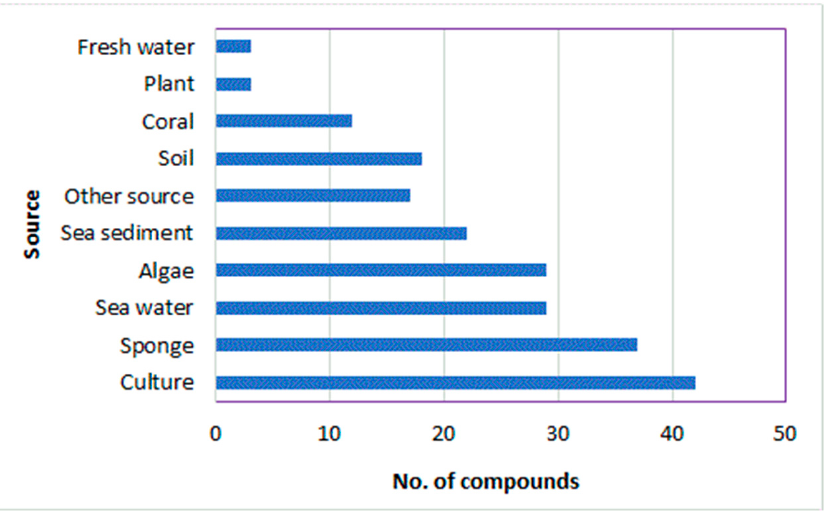
Figure 17. Number of metabolites reported from A. ochraceus isolated from various sources.